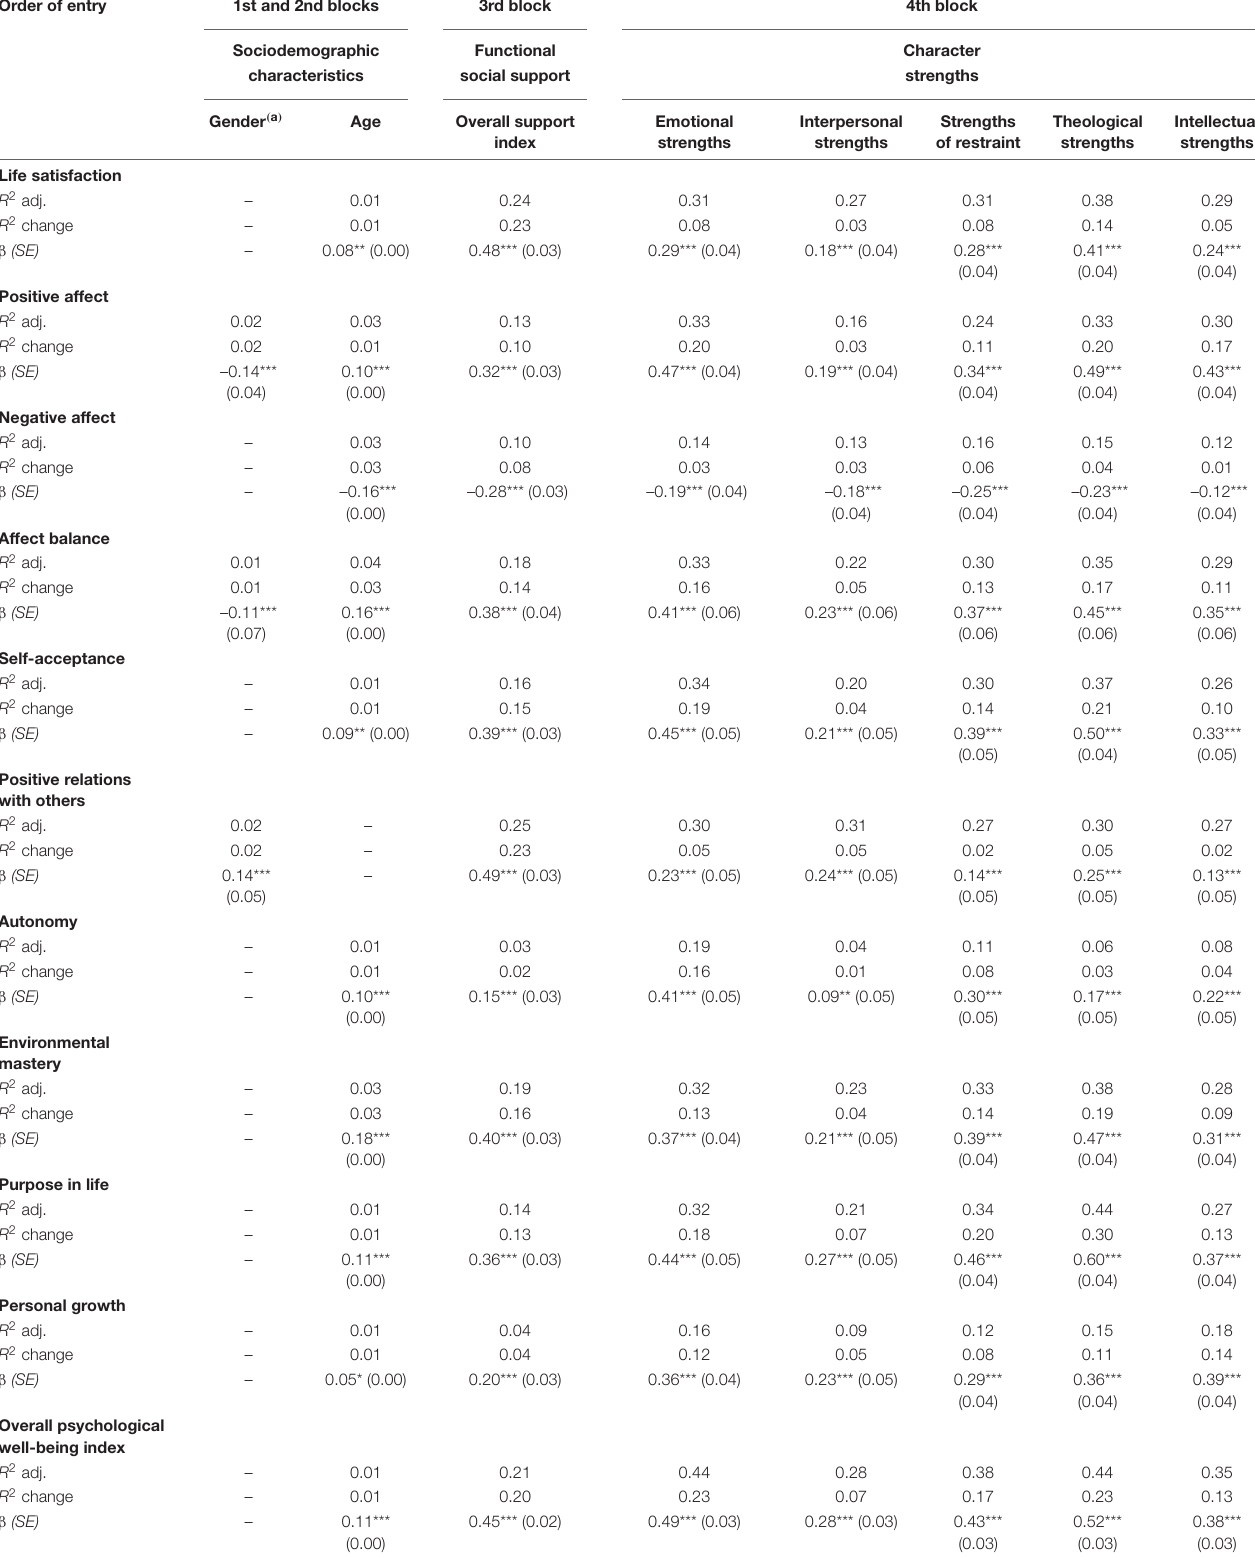
TABLE 4 | Predicting subjective well-being, psychological well-being, and symptoms of psychopathology. Order of